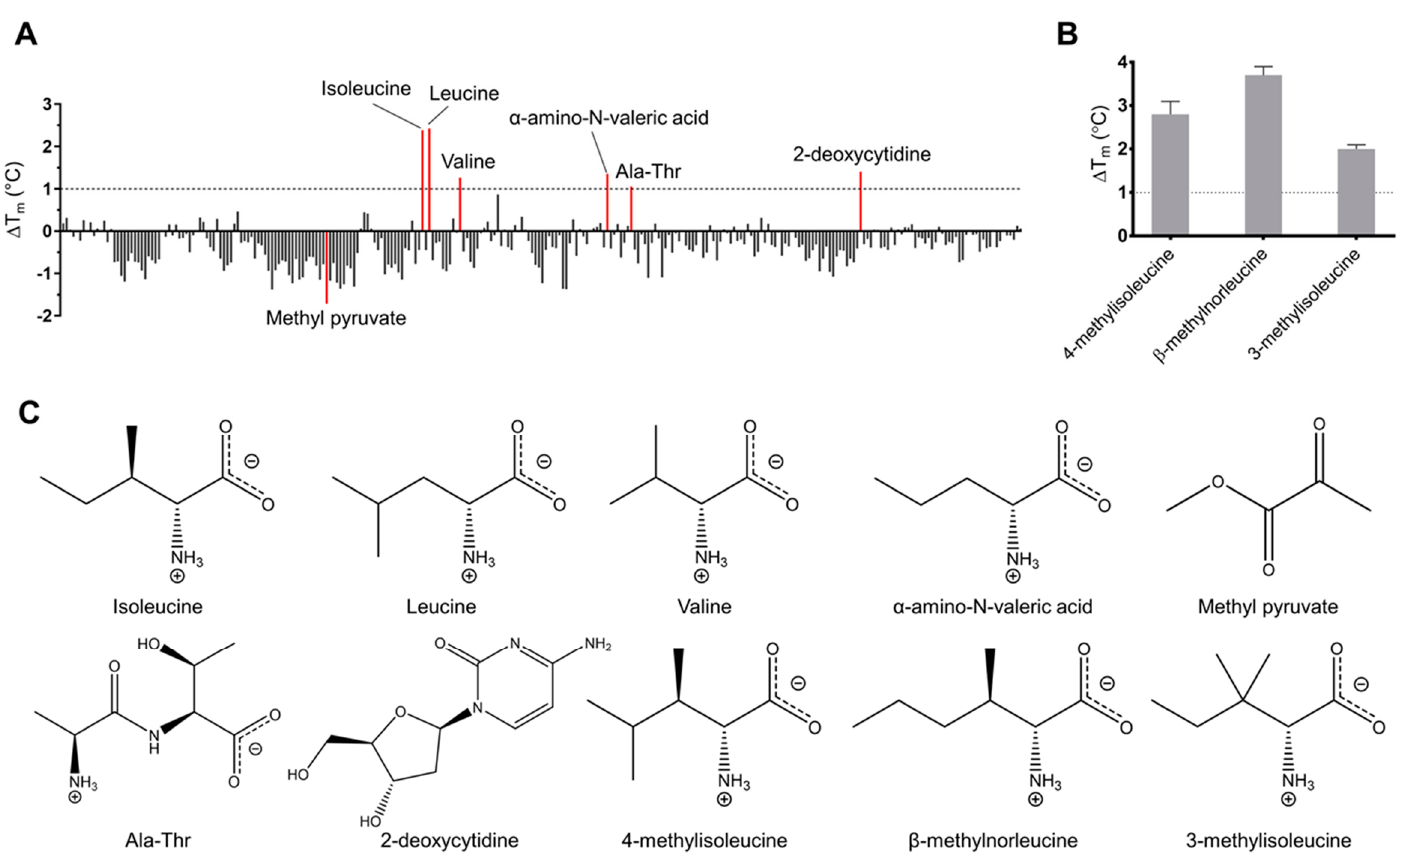
Figure 1. Results of thermal shift assay-based screening of recombinant Tlp3 LBD against ( A ) Biolog small molecule libraries PM1, PM3B, and PM5, and ( B ) candidate ligands identified by in silico screening. The Δ Tm threshold above which the small molecule was considered to be a potential binder was set at 1.0 °C. The compound that caused the most significant destabilisation of the protein (methyl pyruvate, Δ T m = − 1.8 °C) was also selected for further testing as a potential binder. ( C ) Structures of all new potential Tlp3 LBD ligands identified by screening against PM libraries and by in silico screening, drawn in MarvinSketch [54] .